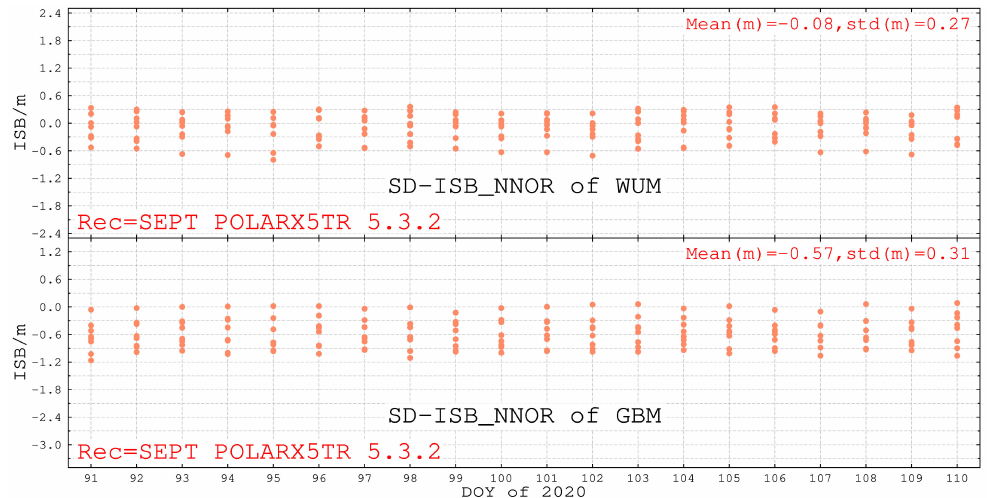
Figure 12. The single di ff erence ISB series of SEPT POLARX5TR 5.3.2 by using GBM and WUM precise products from DOY 091 to 110, 2020. Reference station: